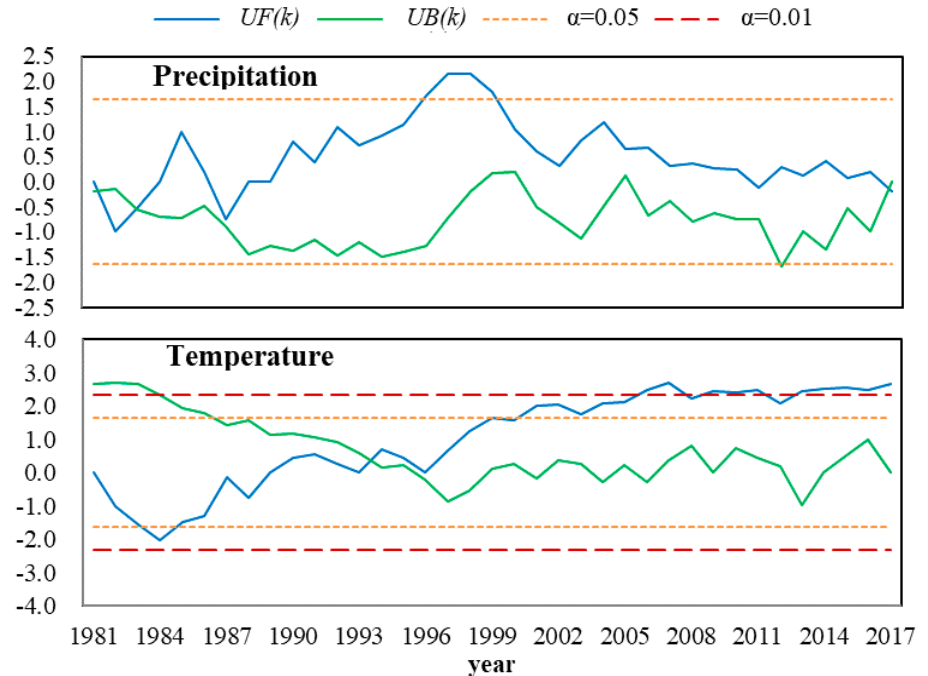
Figure 5. Precipitation and temperature Trend-Free Pre-Whitening (TFPW)-Mann–Kendall test results. UF and UB are the curves calculated using the Mann–Kendall test method. If the intersection of the curve of UF and the curve of UB is between the significant horizontal lines, the intersection is the starting moment of the sequence abrupt change point, and we can regard it as the beginning of an abrupt change point.